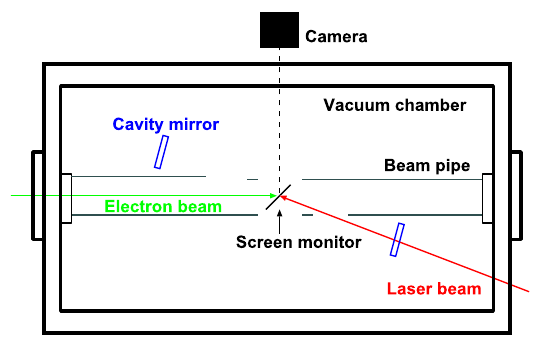
FIG. 12. Schematic figure of the inner layout of the vacuum chamber. A removable screen monitor was located at the